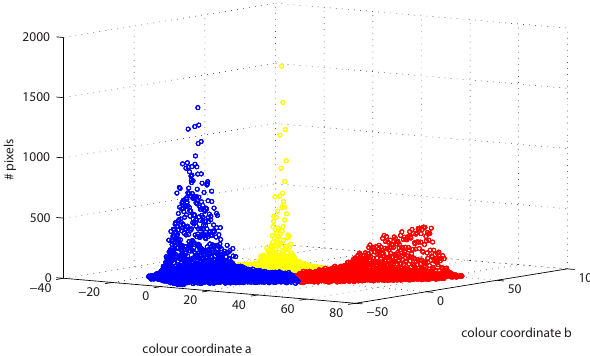
Figure 7. Three-dimensional view of the a and b domain. Example for one image. Clusters segmented in the three colours: blue, red and yellow. The position of each dot in the a and b plane is related to the colour and its vertical position indicates the number of all pixels with the same colour